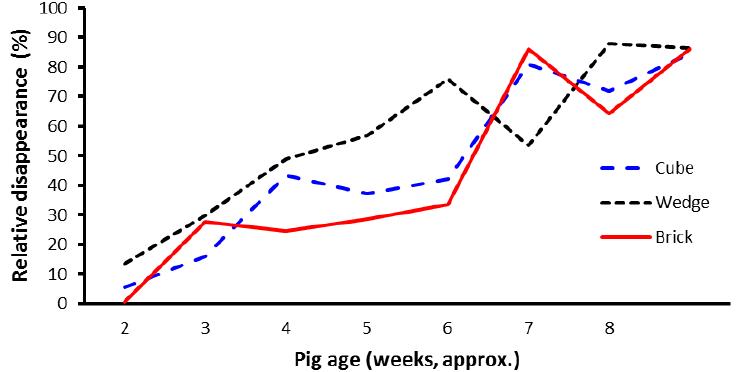
Figure 5. Relative disappearance of the shaped blocks over the course of the experiment. The values shown are mean percentages adjusted for number of pigs in the litter. Pigs were weaned at about age 28 days.